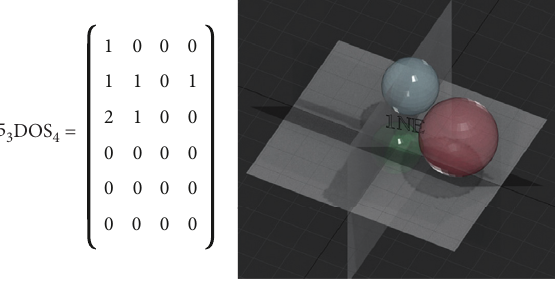
Figure 17: R5 3 DOS-intersection model in Example 2(a).